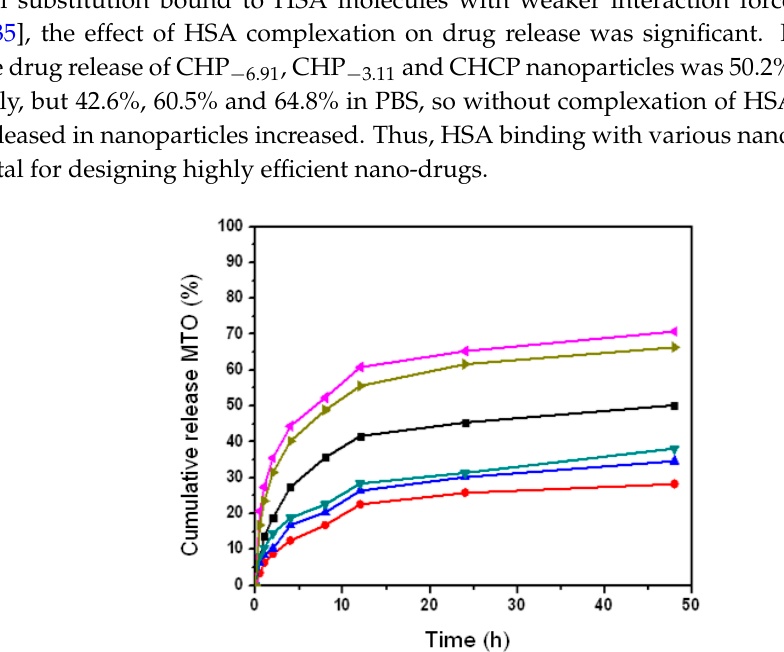
Figure 11. The mitoxantrone (MTO) release of pullulan nanoparticles upon human serum albumin ‚ İ (HSA) complexation in PBS at 37 ˝ C in vitro ( : CHP ´ 6.91 , (cid:78) : CHP ´ 3.11 , : CHCP); and in the HSA (HSA) complexation in PBS at 37 °C in vitro ( ● : CHP − 6.91 , ▲ : CHP − 3.11 , ▼ : CHCP); and in the HSA release § đ media ( ■ : CHP − 6.91 , ► : CHP − 3.11 , ◄ : CHCP). release media ( (cid:4) : CHP ´ 6.91 , : CHP ´ 3.11 , :